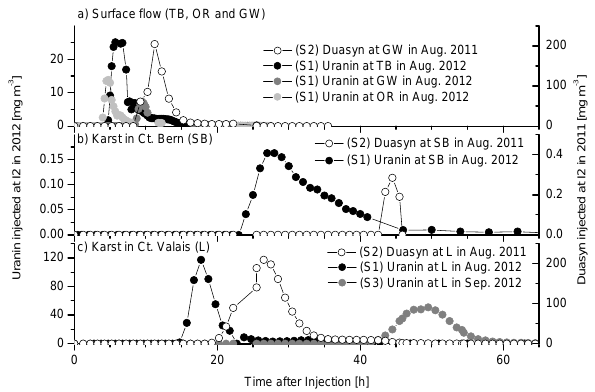
Fig. 6. Tracer breakthrough curves after injection at the southern location (I2) under three distinct meteorological conditions (S1, S2 and S3; Fig. 4): (a) concentrations in surface runoff at TB, OR and GW; (b) concentrations in karstic spring SB on the northern side of the glacier; and (c) concentrations in karstic spring L on the south- ern side of the